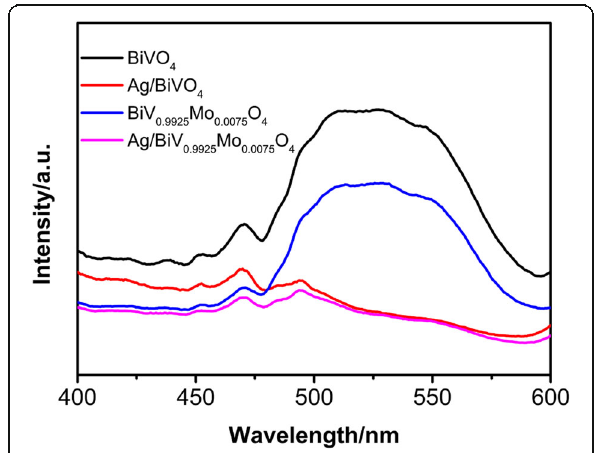
Fig. 9 Five cycle runs of Ag/BiV 0.9925 Mo 0.0075 O 4 for the photodegradation of RhB under visible light